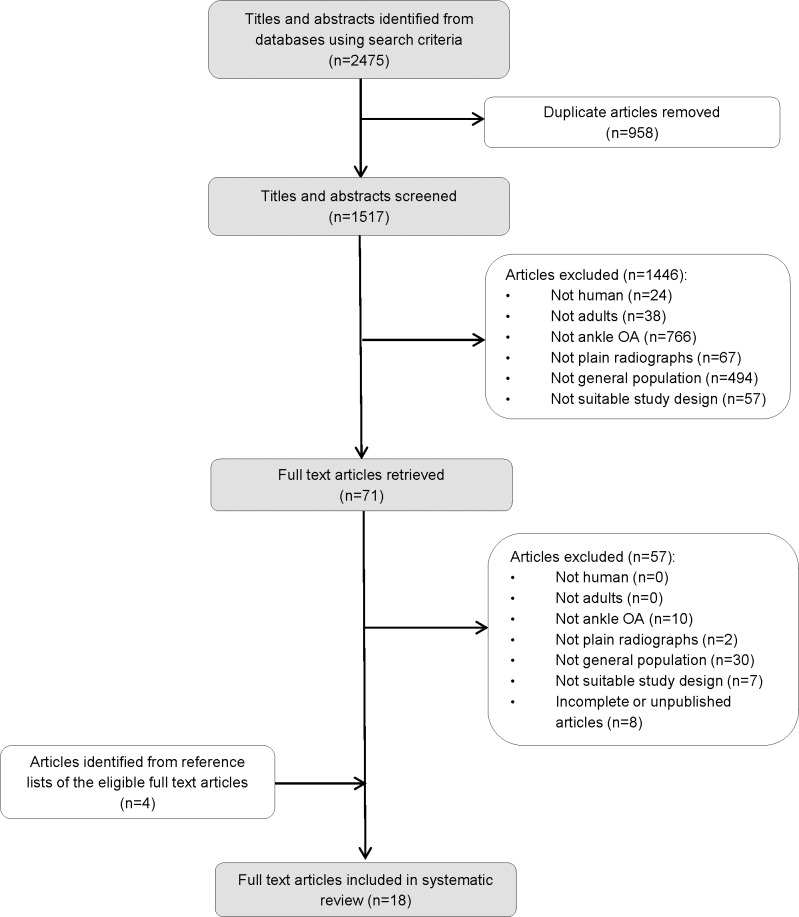
Flow diagram of publications included and excluded at each stage of the review.